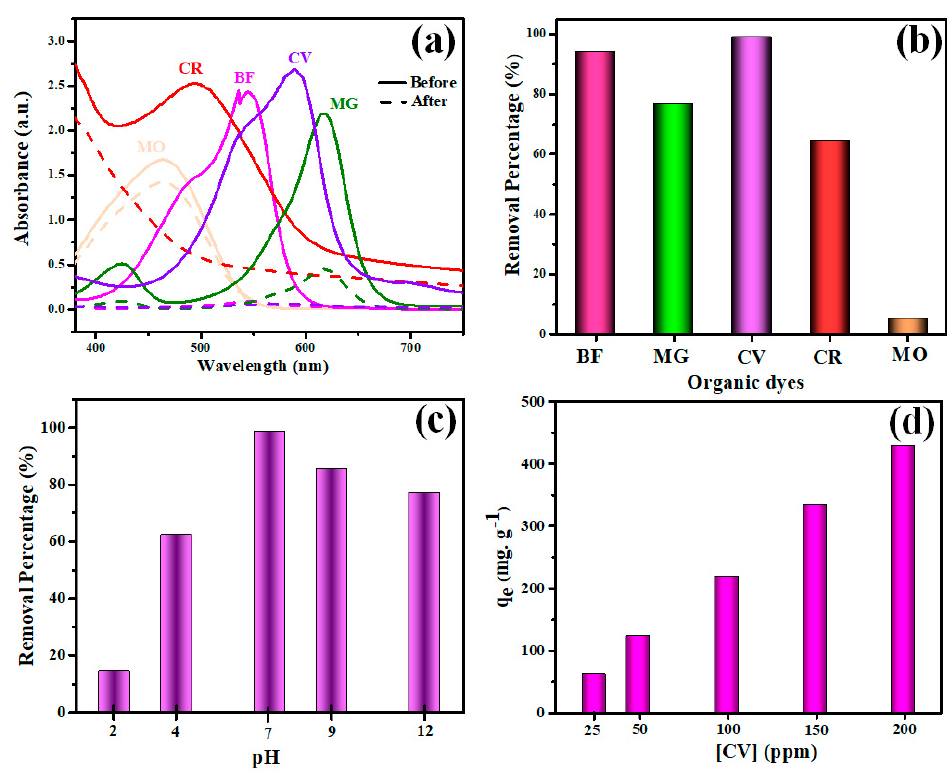
Figure 4. ( a ) UV − Vis curves for various organic dye solutions before and after adsorption, ( b ) adsorption ability, ( c ) pH effect, and ( d ) concentration impact on CV removal by the V 2 O 5 -g-C 3 N 4 nanocomposite.